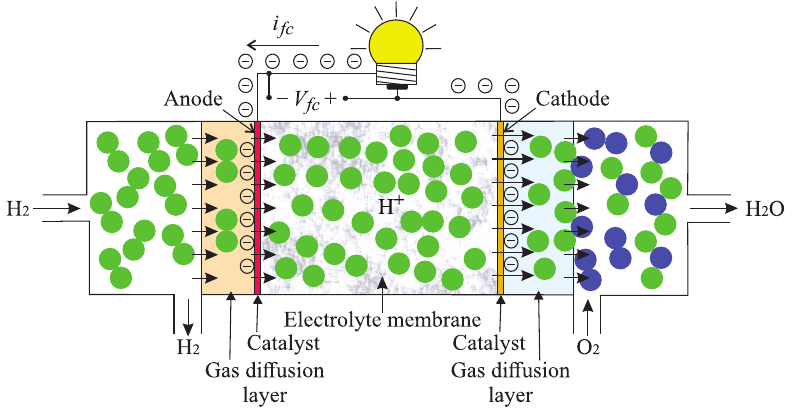
Figure 5. Illustration of a proton exchange membrane fuel cell (PEMFC) construction. Two electrodes, catalyst and gas diffusion layers, and an electrolyte membrane are their main components. Some hydrogen atoms are separated, producing an electron flux (electric current), and then joined with oxygen atoms to form water and